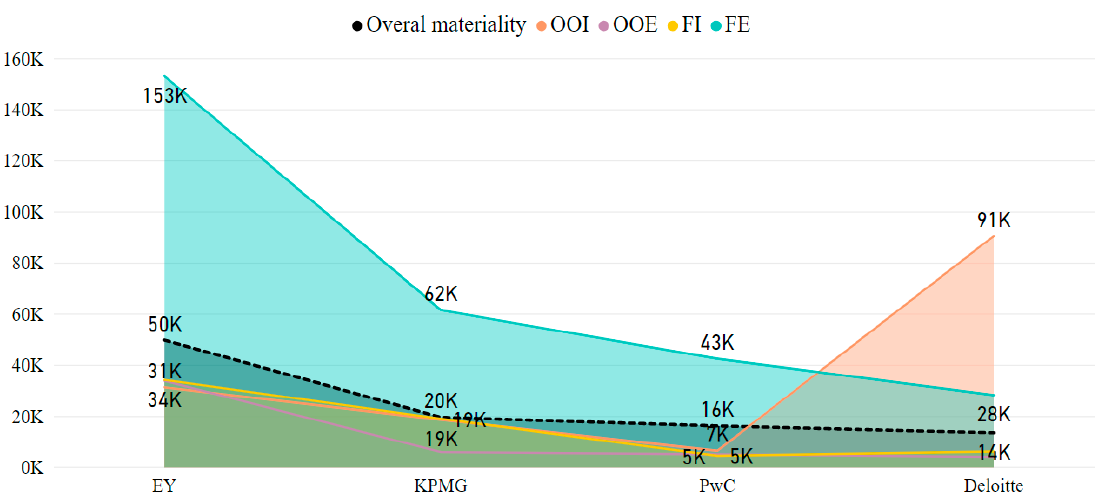
Figure 14. Average values of operating income (OOI), other operating expenses (OOE), financial income (FI), and financial expenses (FE) in relation to the OM—for Big 4 auditing firms. Source: own elaboration based on analyzed data.